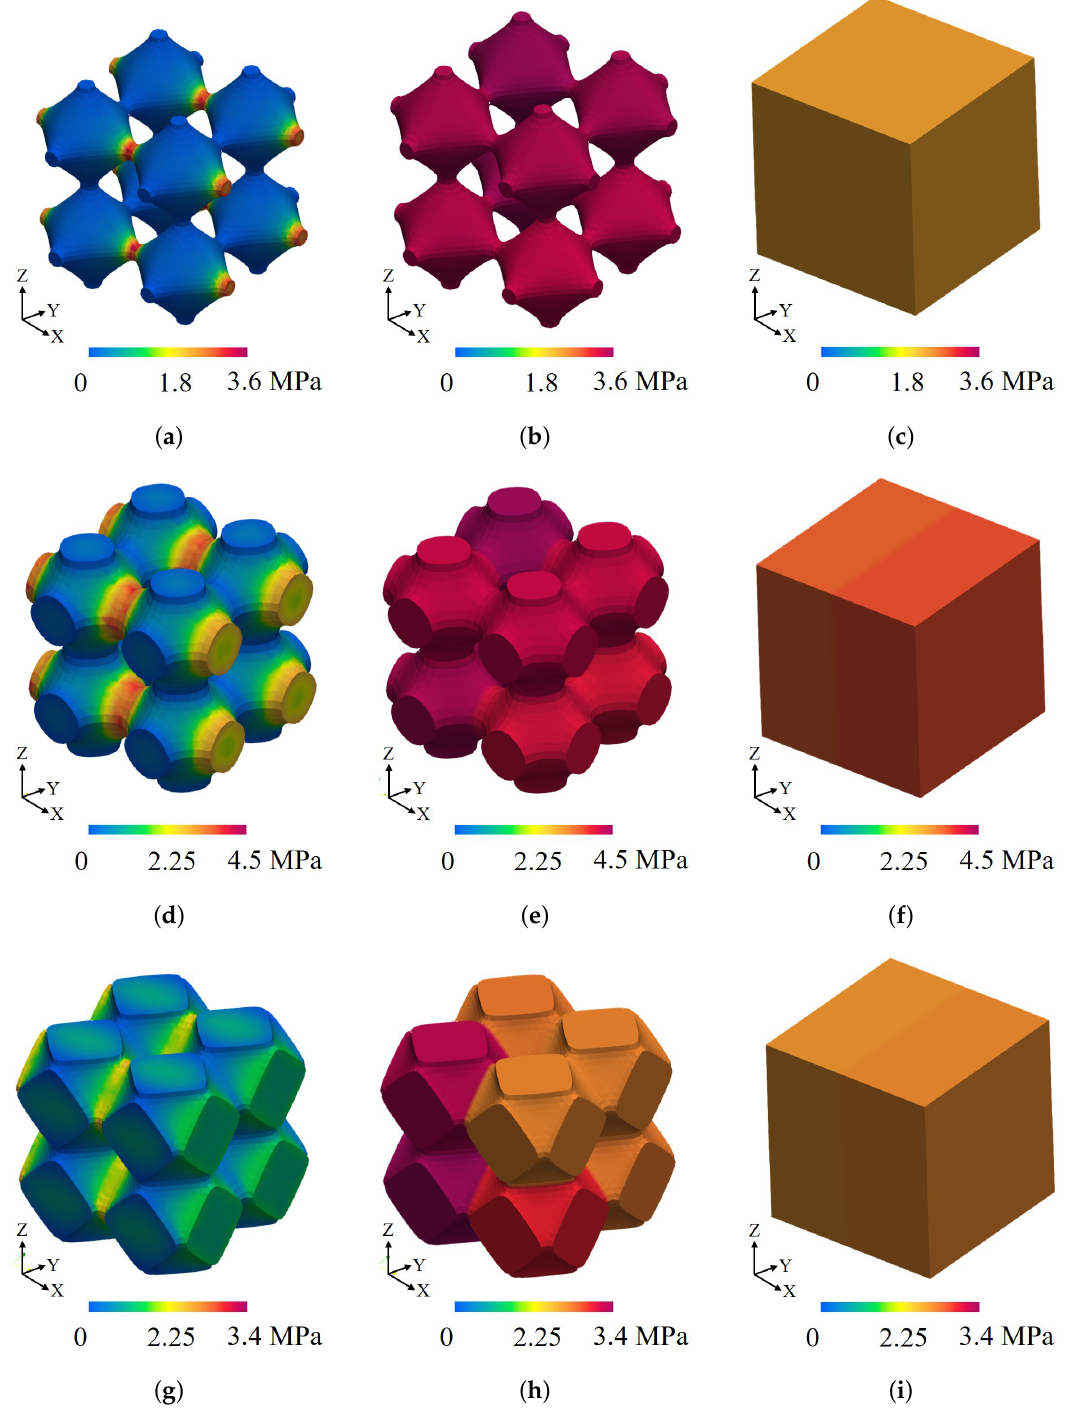
Figure 9. Comparison of the maximum von Mises stress in direct FEA (lattice) and our methodology in Schwarz primitive structures. Domains of eight cells of uniform density. Distribution of von Mises stress in lattice domain with ( a ) ρ = 0.25; ( d ) ρ = 0.50; and ( g ) ρ = 0.75. Maximum von Mises stress per cell in lattice domain with ( b ) ρ = 0.25; ( e ) ρ = 0.50; and ( h ) ρ = 0.75. Maximum von Mises stress per cell in homogeneous domain with ( c ) ρ = 0.25; ( f ) ρ = 0.50; and ( i ) ρ = 0.75. Detailed results in Table